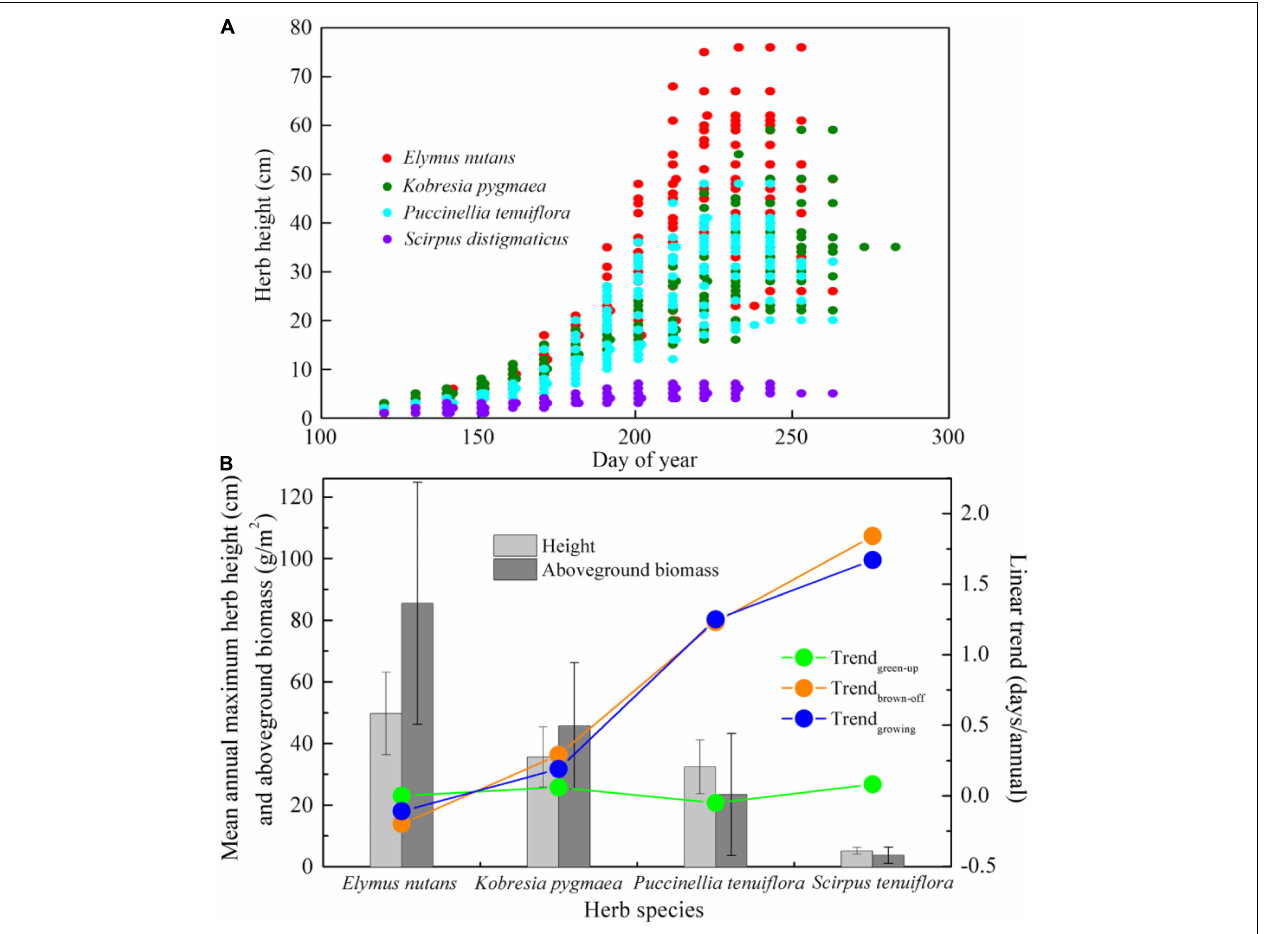
FIGURE 5 | (A) Distribution of herb heights of four typical alpine herb species ( Elymus nutans , Kobresia pygmaea , Puccinellia tenuiflora , and Scirpus distigmaticus ) during the growing season from 1994 to 2012 in Henan Station. (B) Comparison among different herb species in multi-year mean annual maximum herb height, aboveground biomass, and linear trends of green-up, brown-off date, and growing season length from 1989 to 2018 in Henan Station. Trend green − up , Trend brown − off , and Trend growing represent the linear trends of the four herbs green-up dates, brown-off dates, and growing season lengths,